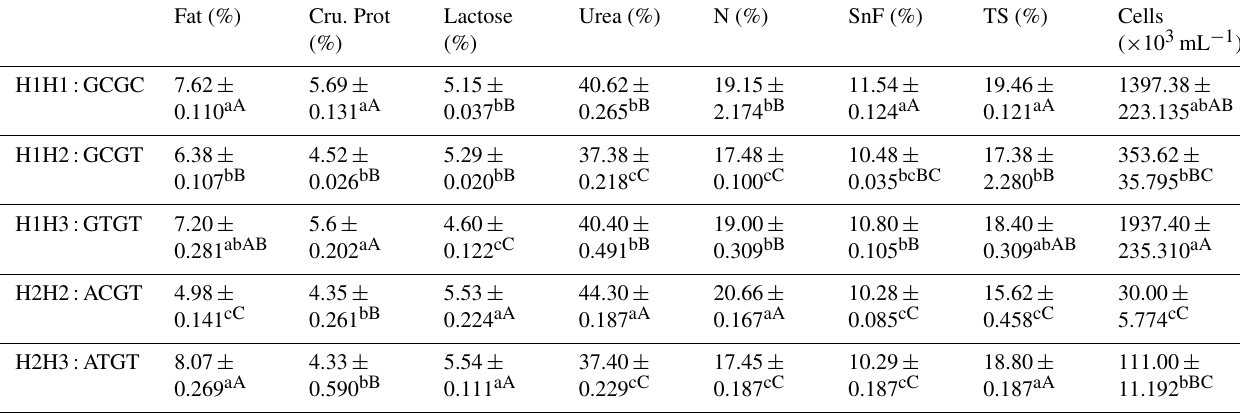
Table A8. Association analysis of haplotype milk production performance.